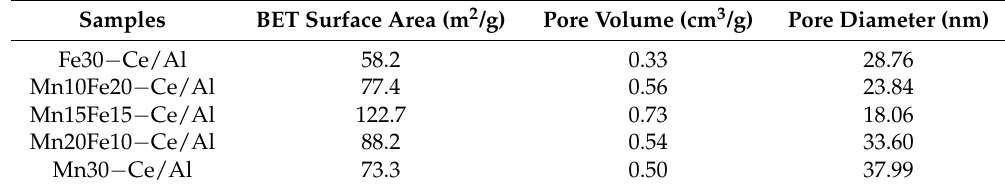
Table 1. Physical properties of the nanocatalysts with different Mn/Fe ratios.